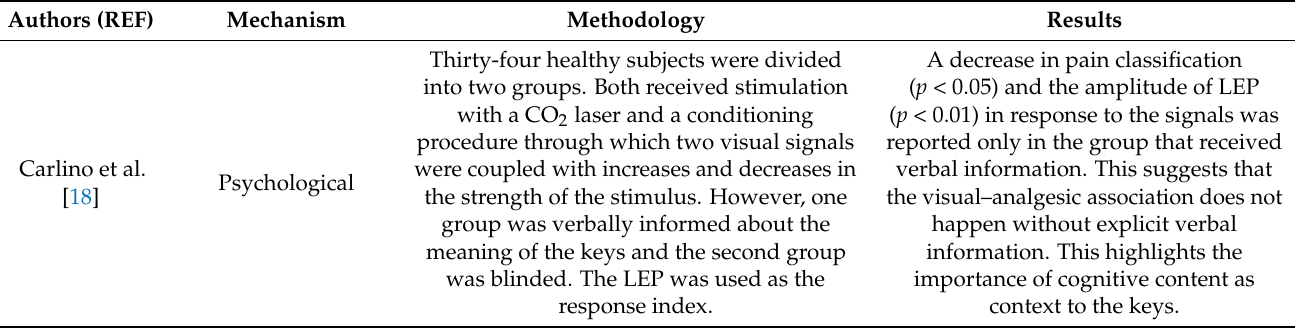
Table 1. Psycho-neuro-endocrine-immune mechanisms of the placebo